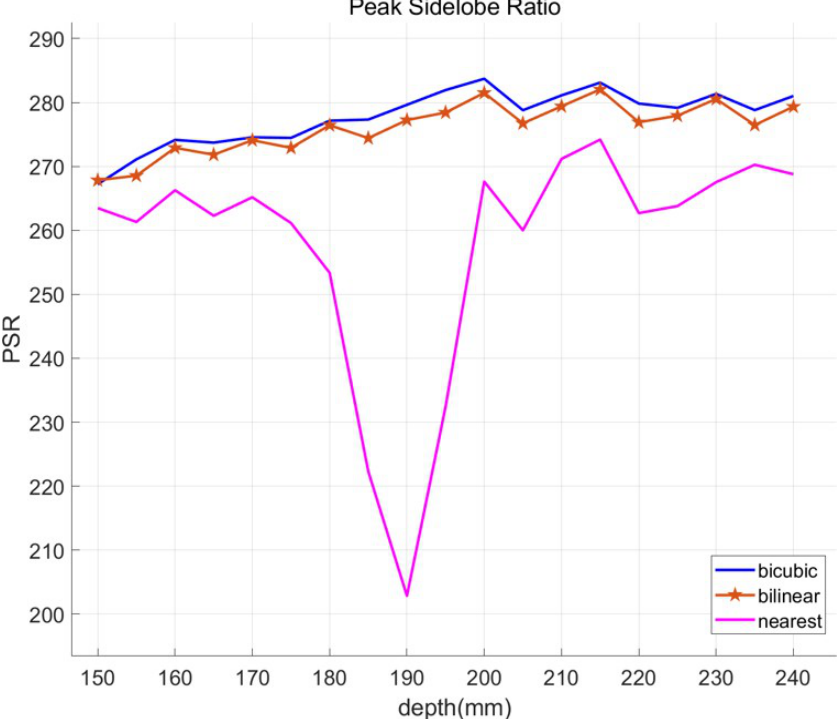
Figure 10. PSR results of simulation by digital zooming VCR with “bicubic” (blue line), “bilinear” (orange line), and “nearest” (magenta line) interpolation